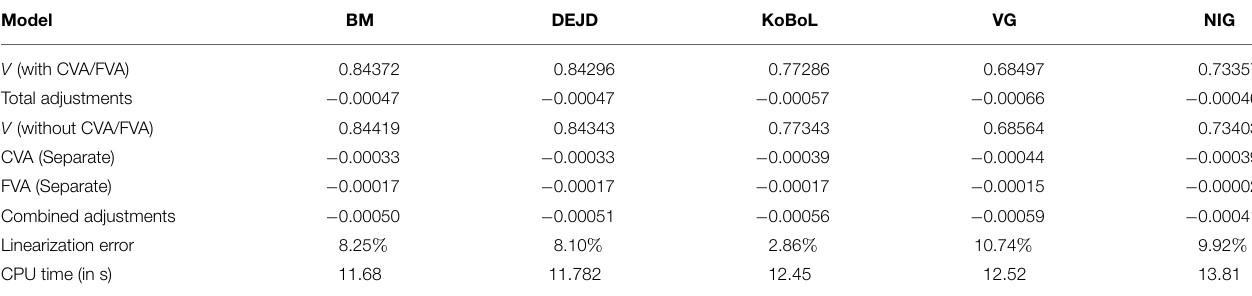
TABLE 14 | Prices of first-touch digitial for different models as of 28 May 2015, time to maturity T = 0 . 0877 , spot S = 27 , 454 . 31 , barrier H = 27 , 000 , risk-free rate r = 0 . 25 % , collateral rate r C = 1 % , funding rate r F = 1 . 7 % default intensity λ = 0 . 05 , recovery rate R B = 0 . 4 , collateral threshold H B = 0 . 5 . Model